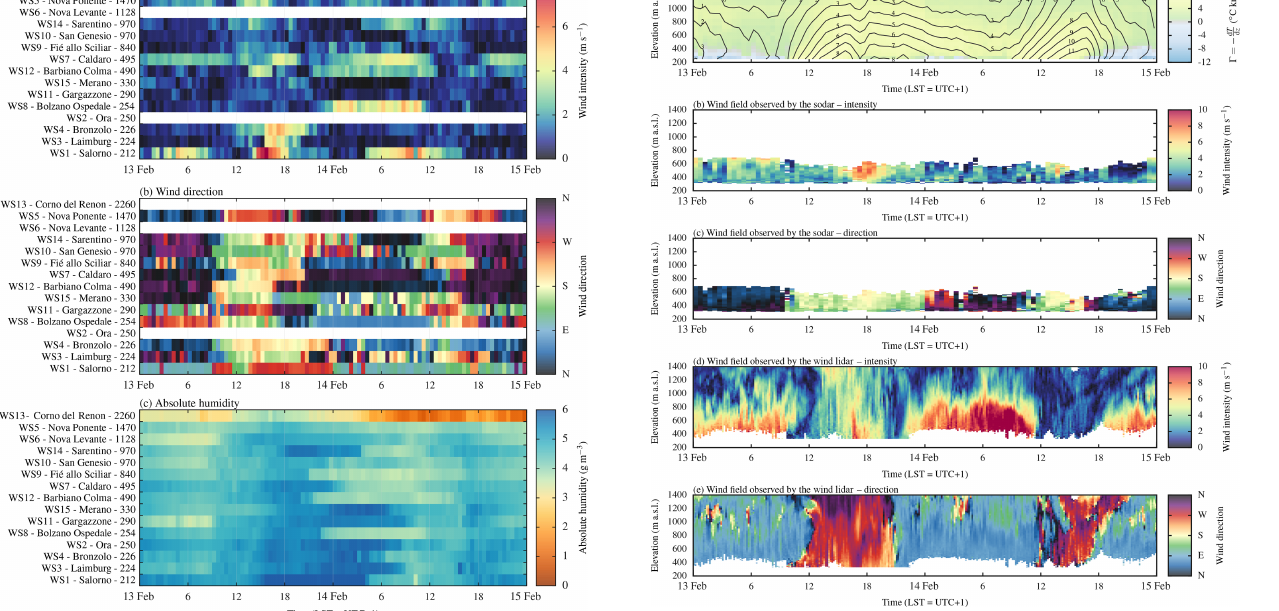
Figure 6. Time evolution of the wind intensity (a) , the wind direc- tion (b) and the absolute humidity (c) measured by the 15 surface weather stations used during BTEX (see Table 1). The absolute hu- midity was computed from data of relative humidity, air temperature and atmospheric pressure. Weather stations are ordered according to their elevation, with the aim of displaying a pseudovertical distribu- tion of the observed quantities.